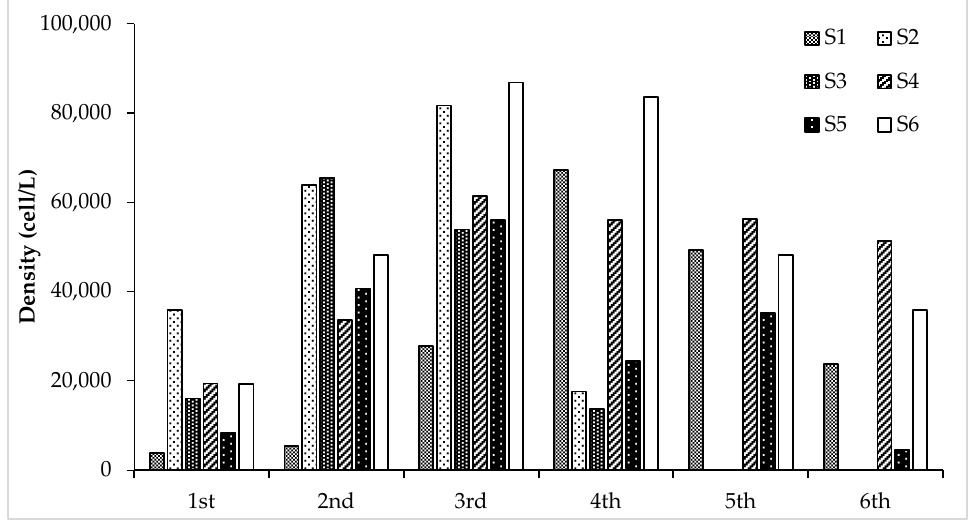
Figure 4. Phytoplankton density over the sampling intervals.